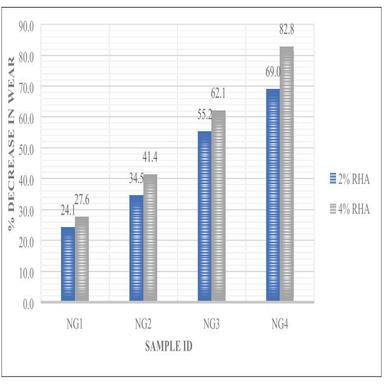
Variation in wear rate with respect to the addition of rice husk ash (150 rpm).